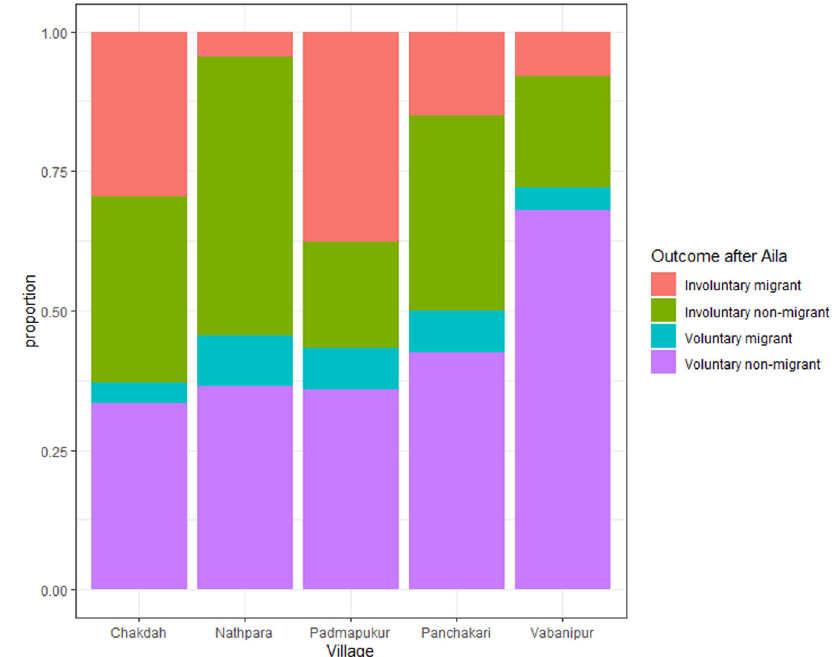
Fig. 3 (Non-)migrants type according to the analytical concept. Source: Authors illustration, fi eld data